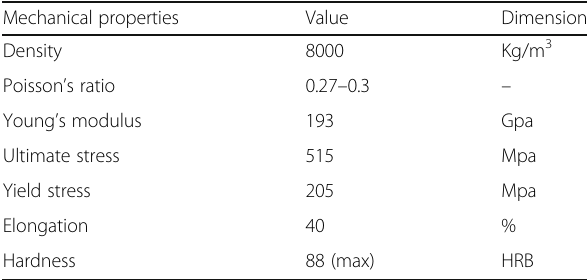
Table 4 The mechanical properties of austenitic stainless